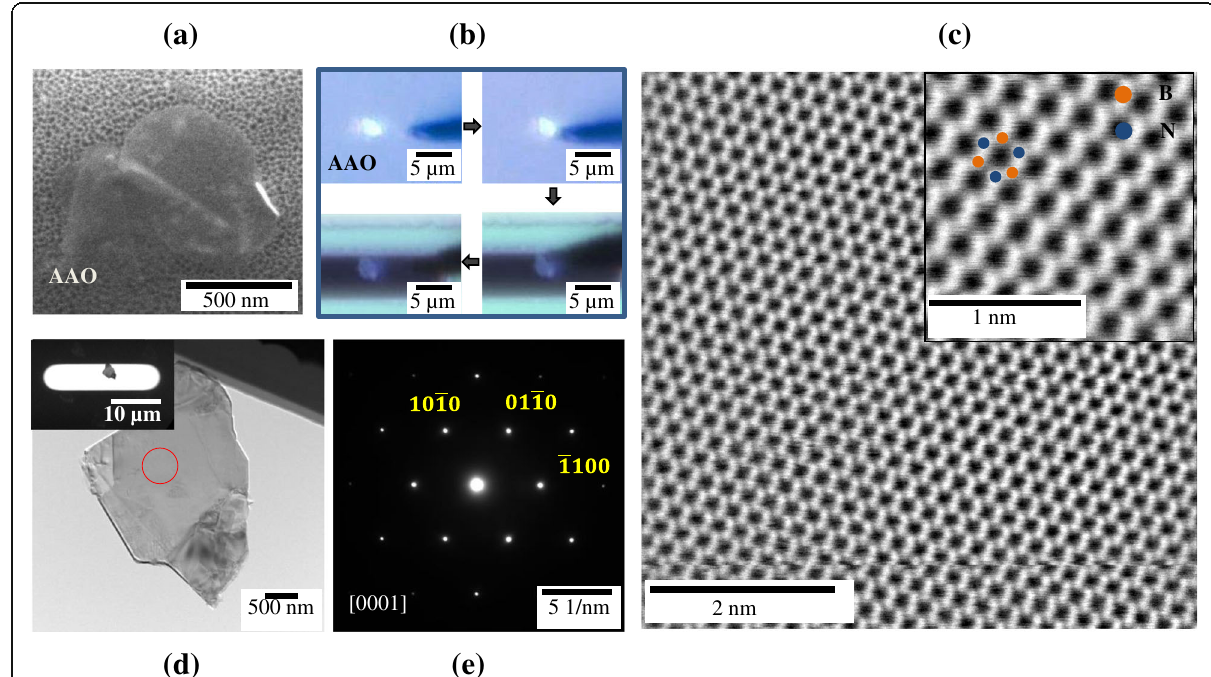
Fig. 3 Transferring process of h-BN 2D flakes on MEMS window from AAO filter a SEM image of h-BN flakes dispersed on AAO. b Transferring process observed by optical microscopy in real time using tip of radius < 100 nm. c TEM image of transferred h-BN single flake on MEMS window. The inset shows low magnification TEM image of sample. d Corresponding SAED pattern of red circled part in c . e STEM-BF image of transferred h-BN flake. Inset reveals the high-magnification image of atomic column of B and